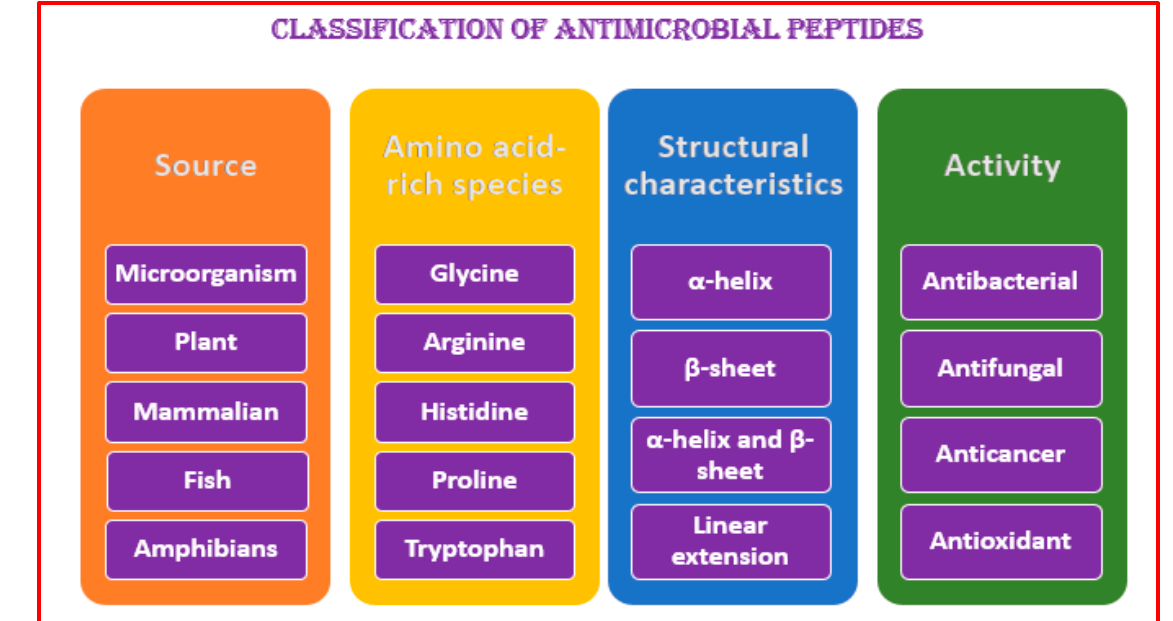
Figure 1. Several ways to classify antimicrobial peptides (AMPs).